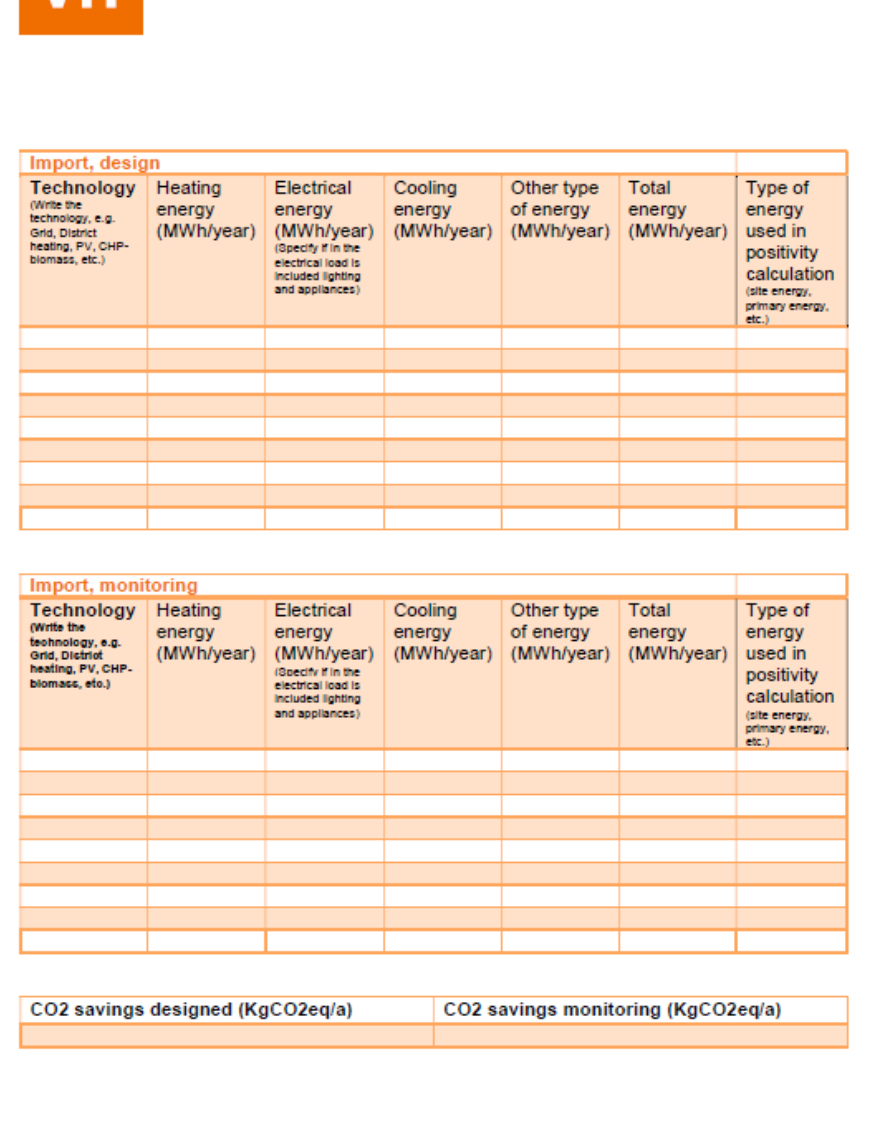
Figure A5. Copy of the fifth page of the questionnaire produced to conduct this study.